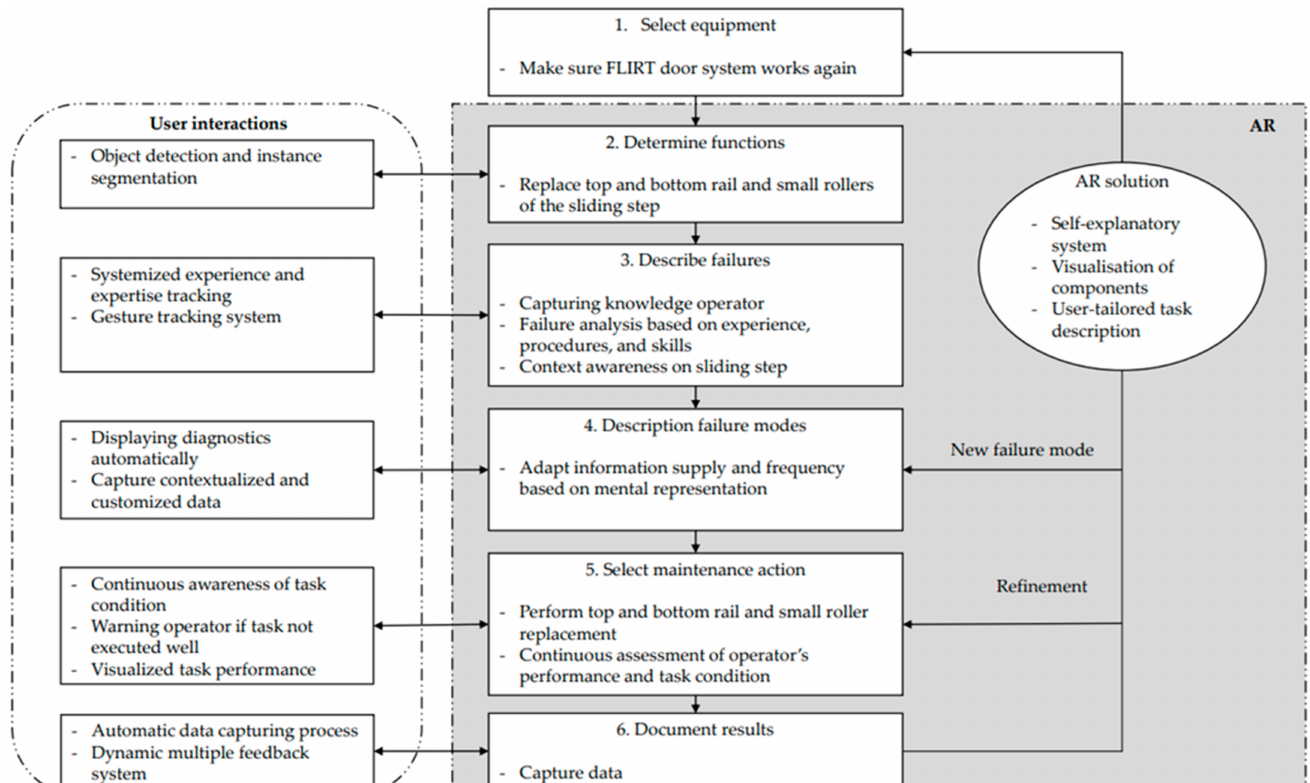
Figure 7. Applied case study for the designed adaptive architectural